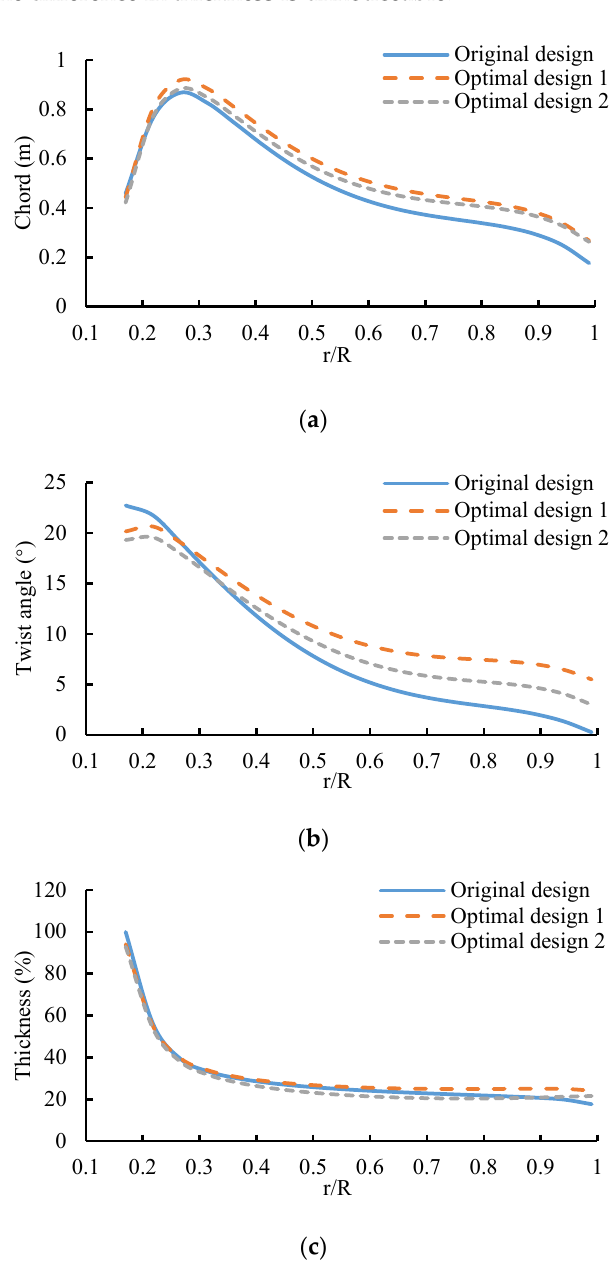
Figure 12. Parameter distributions: ( a ) Chord; ( b ) Twist angle; ( c ) Thickness.